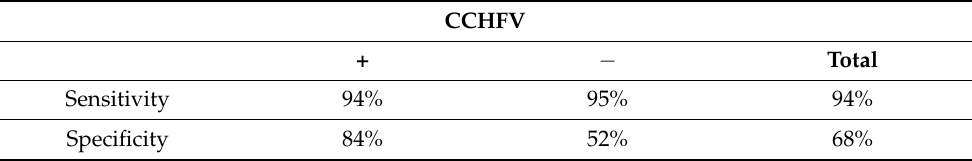
Table 6. Specificity and sensitivity of DUGV